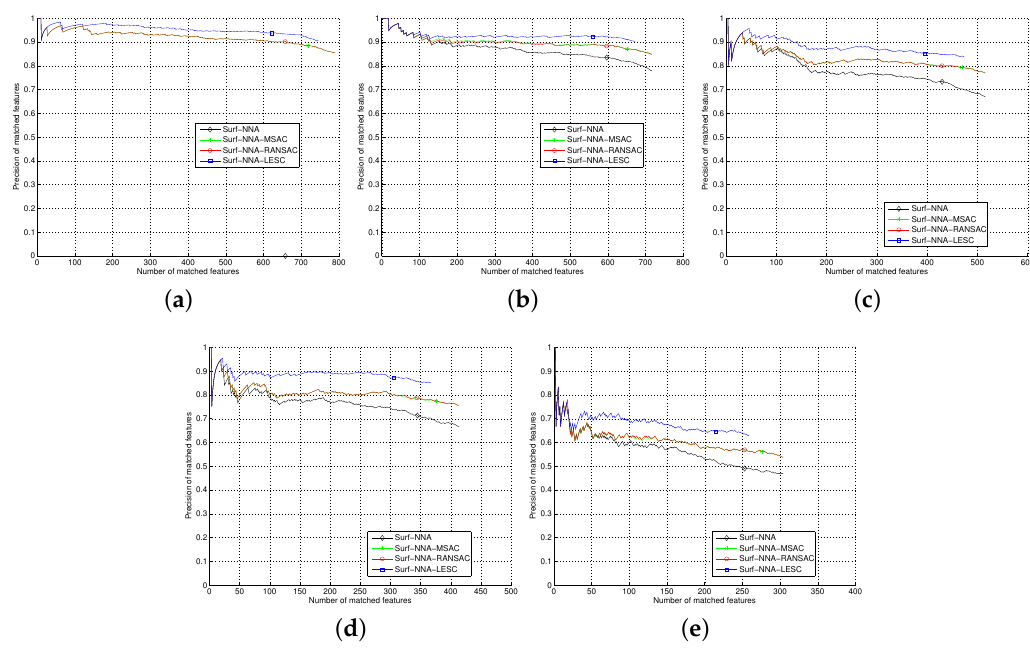
Figure 2. Blur for the structured scene by the Bikes sequence. From ( a ) to ( e ) the degree of change ascends.